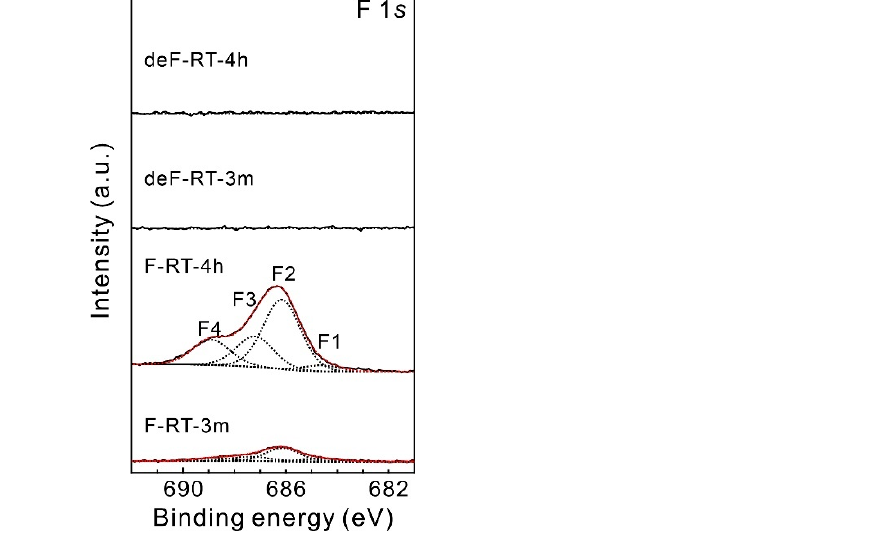
Figure 3. XPS F 1 s narrow spectra of F-SWCNTs and deF-SWCNTs. The black and red dotted lines represent deconvoluted peaks and fitted curves, respectively.